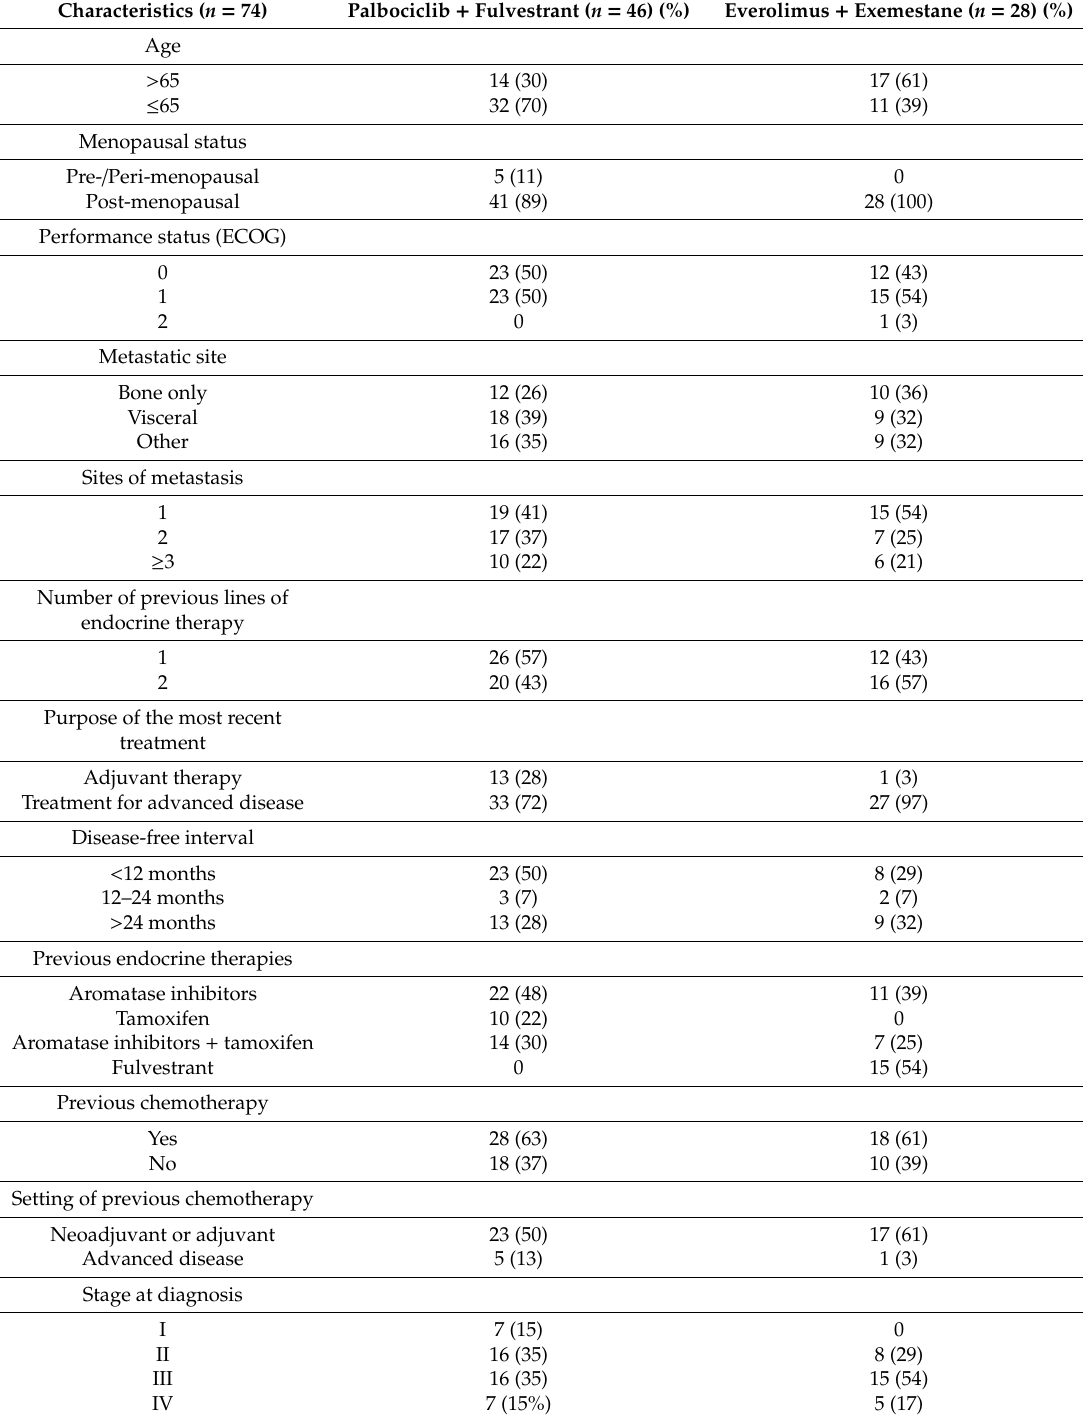
Table 1. Baseline and treatment characteristics ( n =